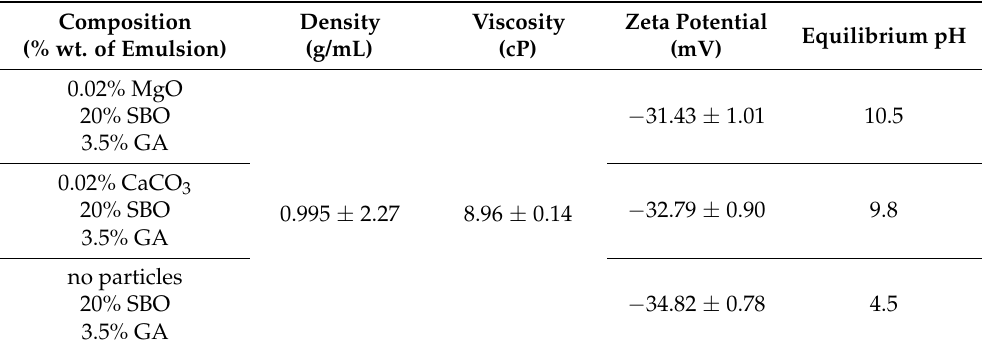
Table 1. Illustrative properties of oil-in-water emulsions constructed with 20% wt. soybean oil (SBO) and stabilized with 3.5% Gum Arabic (GA).